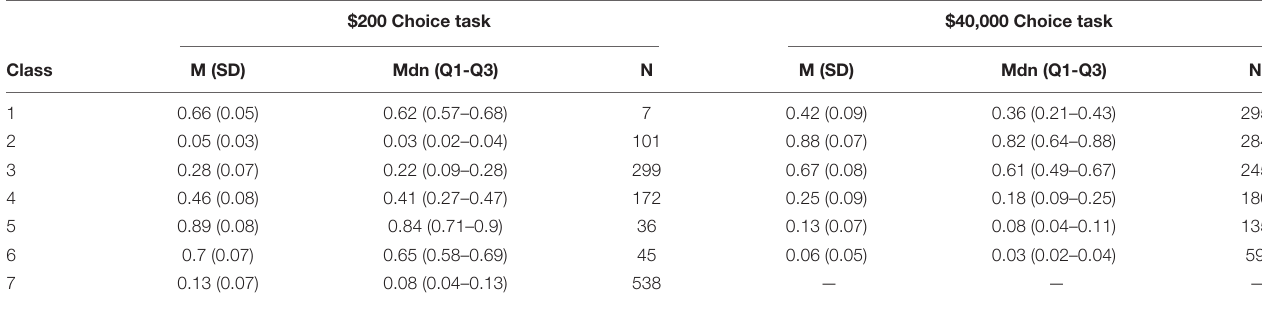
TABLE 4 | Distribution of point-based area under